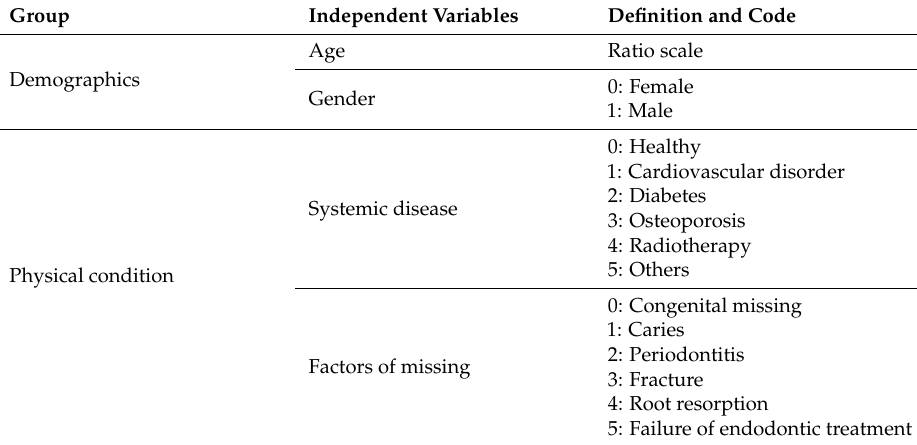
Table 1. Definition of